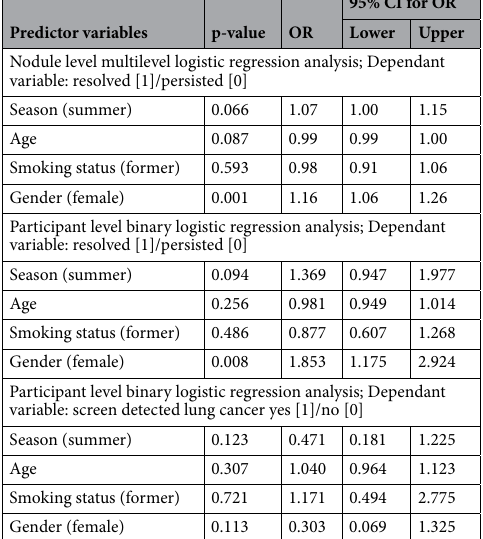
Table 3. Logistic regression analyses of nodule outcome (resolved versus persisted) and screen detected lung cancers during screening rounds two and three of the NELSON trial. (Reference category); OR odds ratio; 95% CI 95% confidence interval for odds